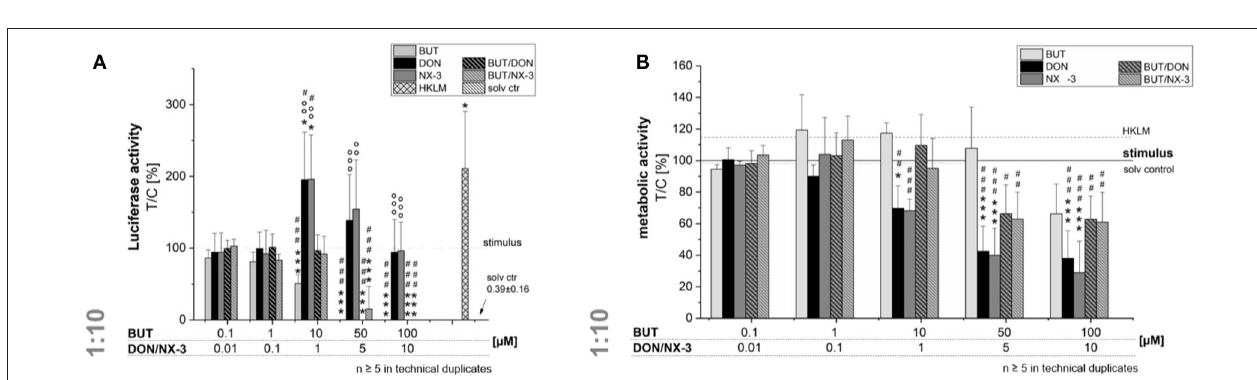
FIGURE 3 | Modulation of NF- κ B-dependent luciferase expression (A) after 2h pre-incubation with BUT (0.1–100 µ M), DON (0.01 µ M-10 µ M), NX-3 (0.01 µ M-10 µ M) and respective 10:1 combinations, followed by 18h co-stimulation with LPS (10ng/mL) in THP1-Lucia TM cells referred to the respective alamarBlue ® -fluorescence intensity (B) . 2% (v/v) water (LC-MS grade) with (dotted line) and without LPS treatment (solv ctr) served as solvent control, HKLM (20 × 10 6 cells/well) as positive control. alamarBlue ® -fluorescence intensity and luciferase activity data are expressed as mean values ± SE of at least five